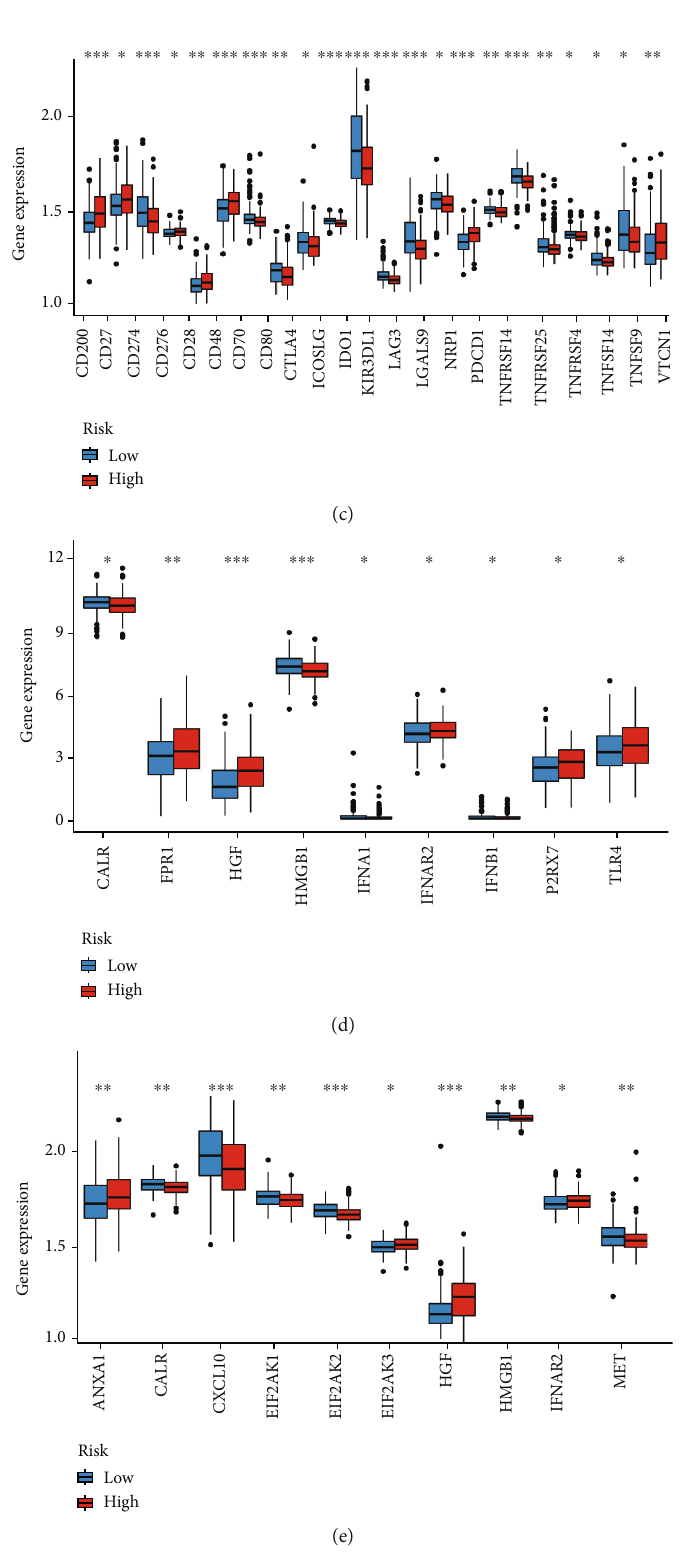
Figure 8: Exploration of immune microenvironment. (a) Distribution of immune cells with signi fi cantly di ff erent in fi ltration levels in the high- and low-risk groups in TCGA dataset ( P < 0 : 05 ). (b, c) The expression of immune checkpoint genes in TCGA and GSE62254 datasets, respectively. (d, e) The expression of immunogenic cell death modulators (ICDs) genes in two datasets ( ∗ P < 0 : 05 , ∗∗ P < 0 : 01 , ∗∗∗ P < 0 : 001